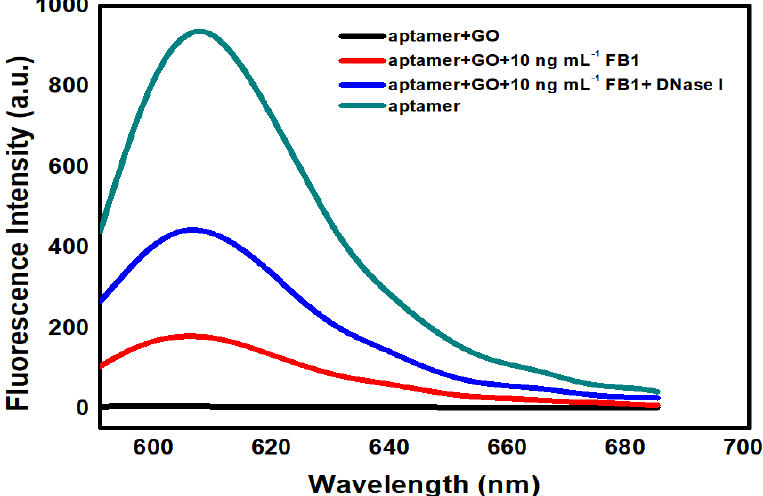
Figure 2. Fluorescence emission spectra of this sensing method in different conditions including the absence (0) of FB 1 , presence of 10 ng mL − 1 FB 1 , and 10 ng mL − 1 FB 1 and 100 U DNase I. Conditions: 100 nM FB 1 aptamer, 20 µ g mL − 1 GO in Tris buffer (10 mM Tris, 120 mM NaCl, 5 mM KCl, 20 mM CaCl 2 , pH 7.0). Excitation wavelength ( λ ex) is set at 585